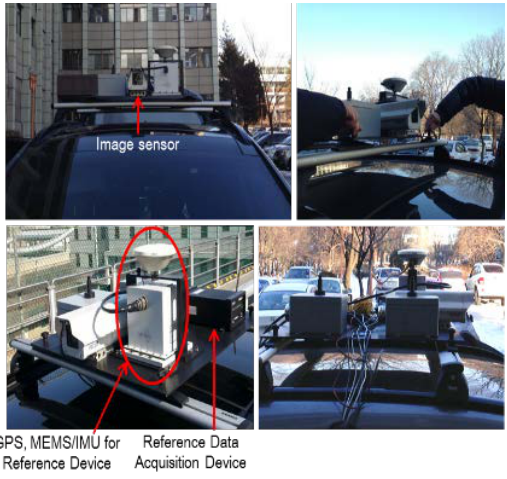
Figure 8. The data acquisition system mounted on the car